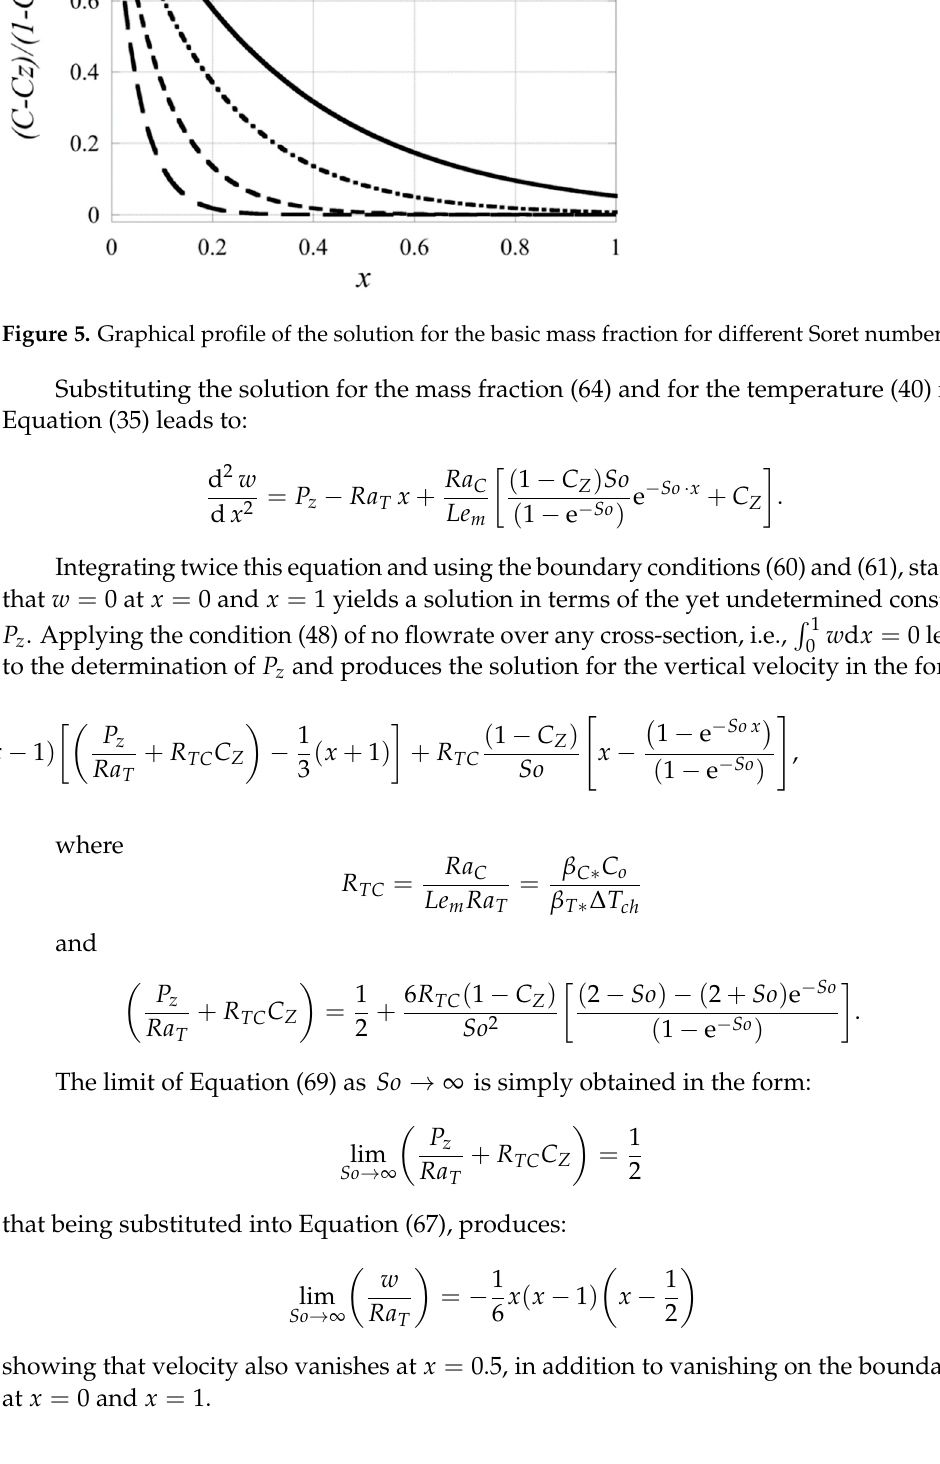
showing that velocity also vanishes at x = 0.5, in addition to vanishing on the boundaries at x = 0 and x =